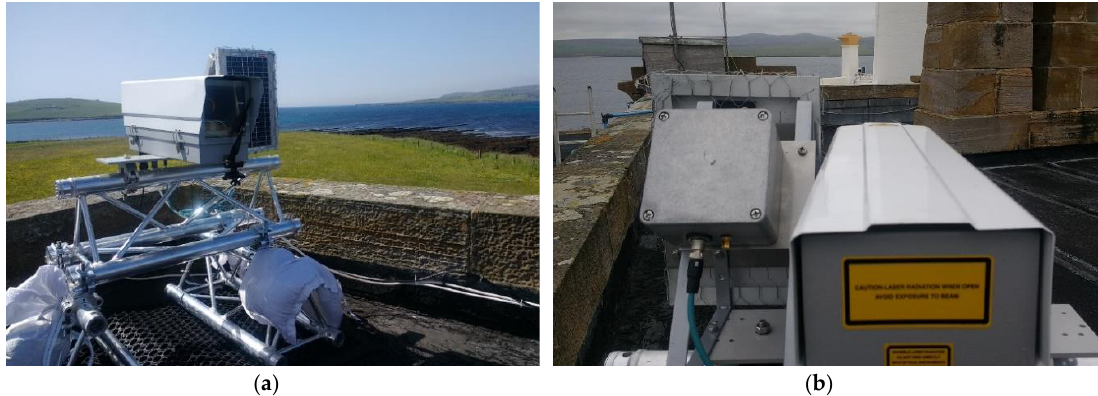
Figure 15. Data rate measurement plot against the daylight and different weather conditions.